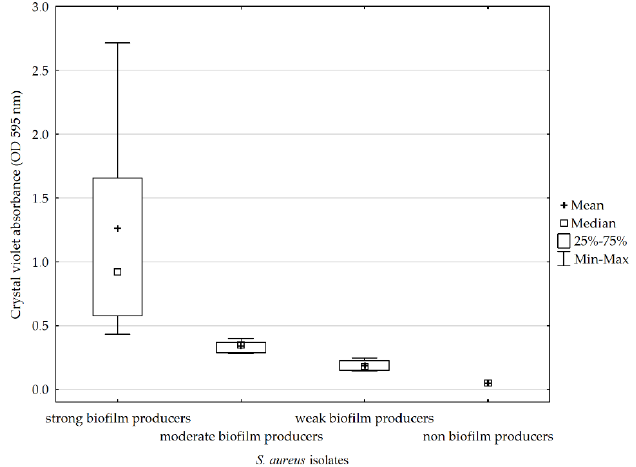
Figure 3. Biofilm–forming ability of S. aureus strains isolated from tracheostomy tubes.